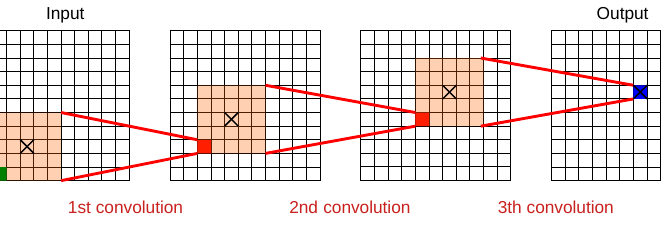
Figure 7. With three layers of 5 × 5 convolutions, the predicted value for a sensor (blue) could be affected by input sensors that are in a 13 × 13